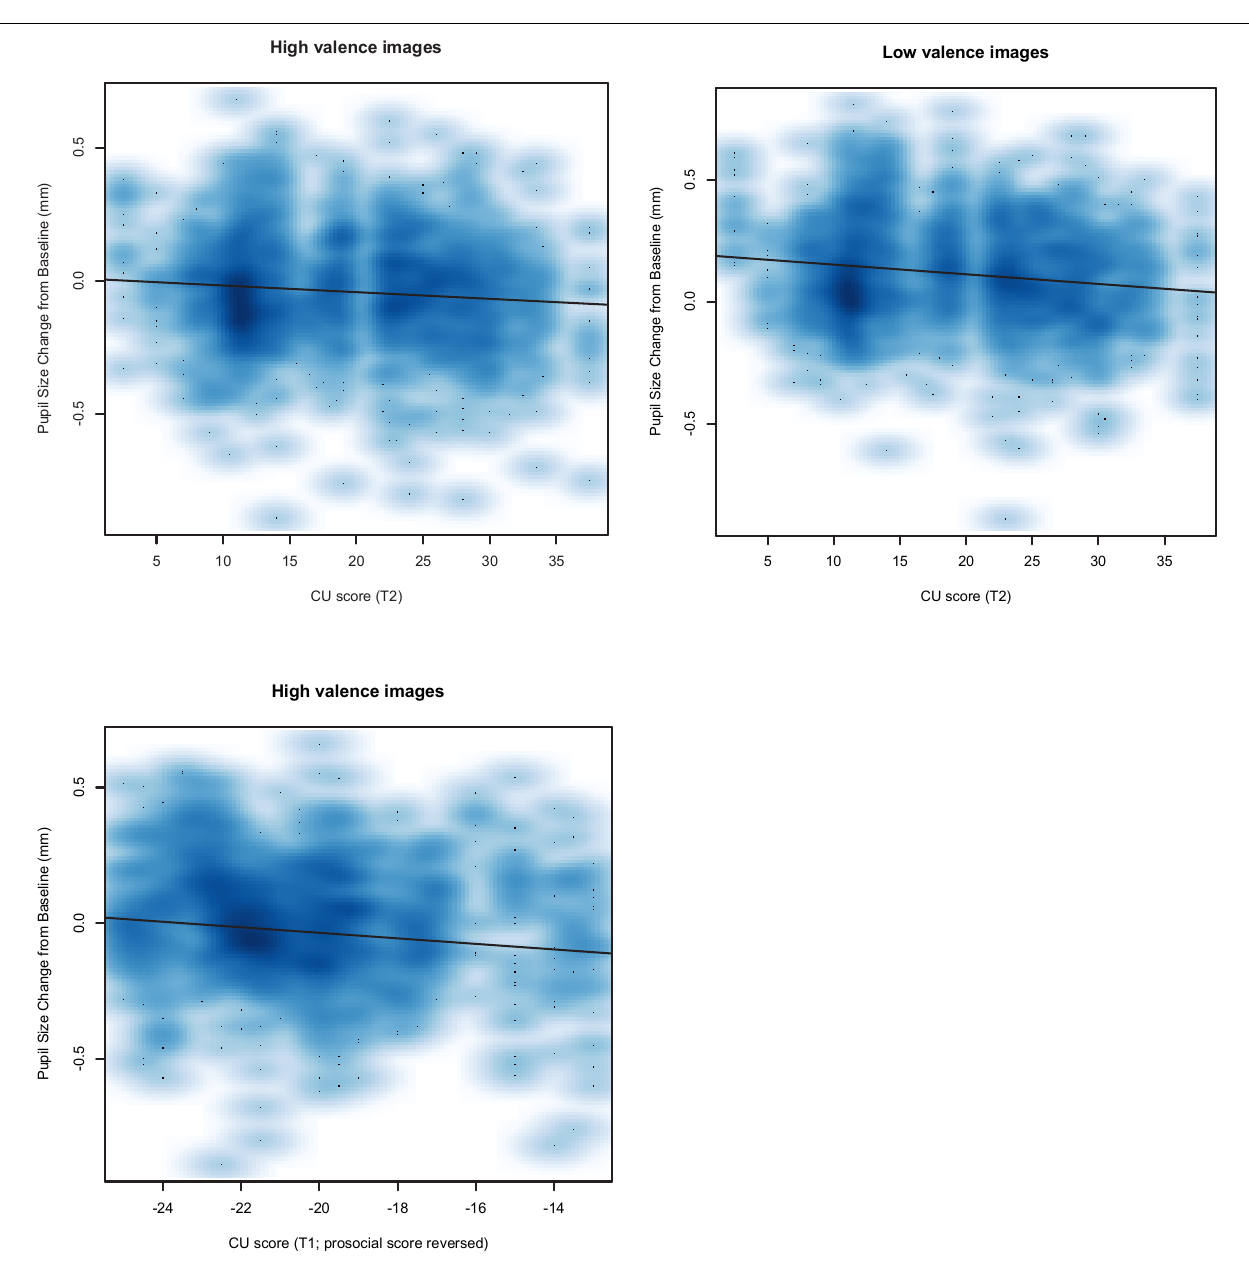
FIGURE 3 | Smoothed scatterplots showing the significant relationship between participants’ CU scores and their change in pupil size from baseline on each